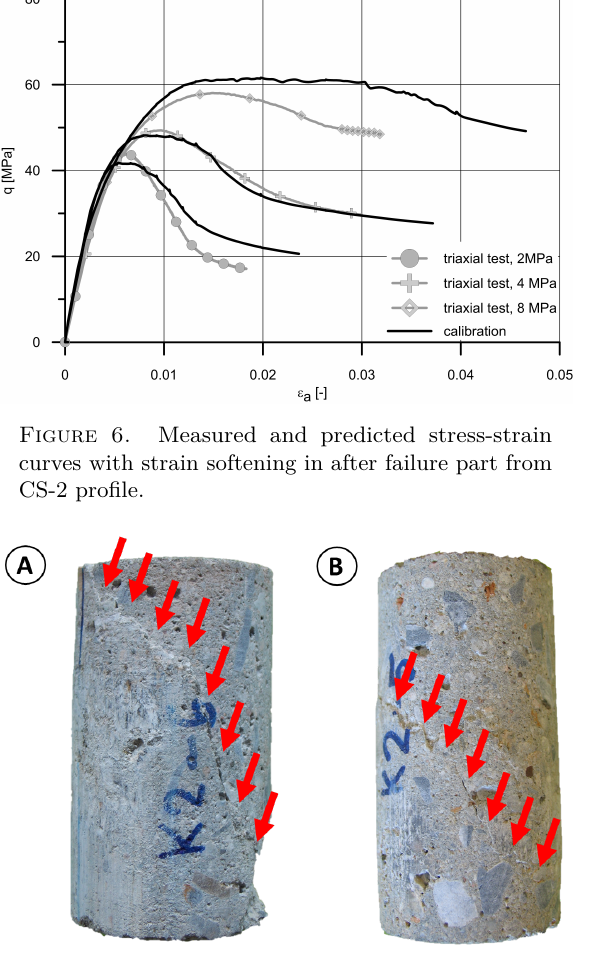
Figure 7. Failure of samples in triaxial loading con- ditions – confining pressure of 4 MPa (A); confining pressure of 8 MPa